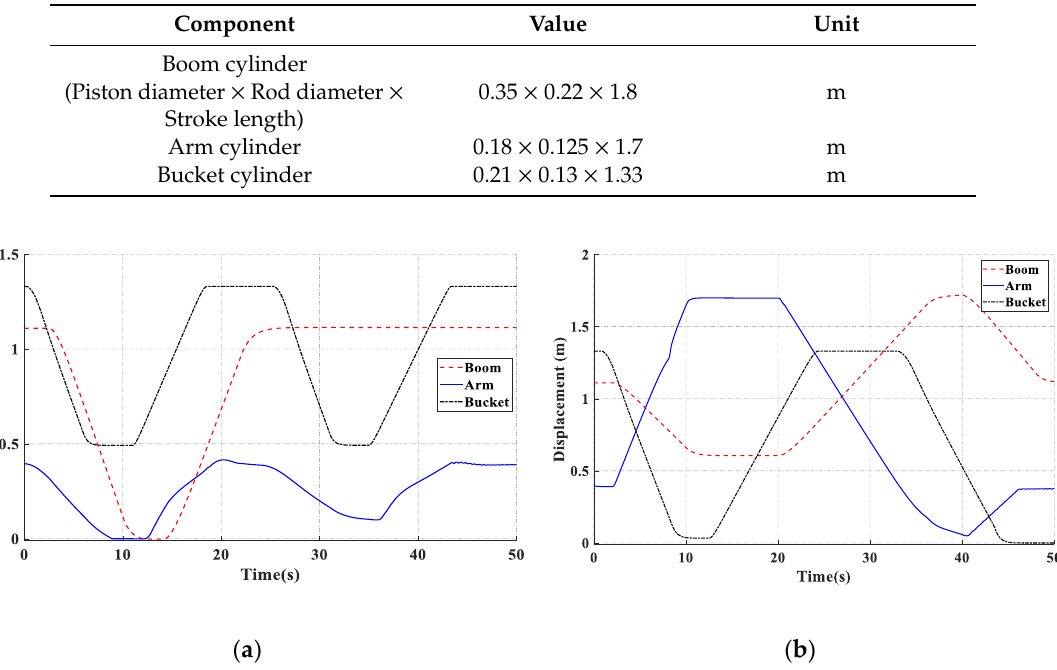
Figure 9. Excavator trajectories of the boom, arm, and bucket with two di ff erent working cycles: ( a ) trajectory 1; ( b ) trajectory 2.